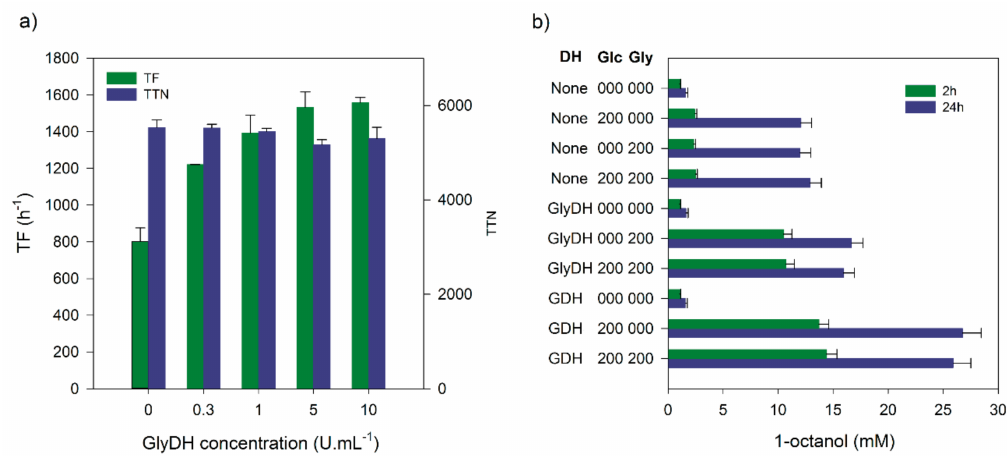
Figure 5. The effect of replacing GDH with GlyDH for cofactor regeneration in reactions performed in vials (40 mL). Reaction conditions: 1 mL (vials) aqueous reaction mixtures containing 2 µ M CYP153A6, 1 µ M FdR, 60 µ M Fdx, 0.1 mM NADH, 0–10 U mL − 1 GlyDH ( a ) or 0/1 U mL − 1 GDH or GlyDH ( b ), 200 mM glycerol ( a ) or 0/200 mM glucose and/or 0/200 mM glycerol ( b ), 50% ( v / v ) CFE from 200 g (wet weight) L − 1 cell suspension, buffer 200 mM Tris-HCl (pH 8) with 250 µ L n -octane